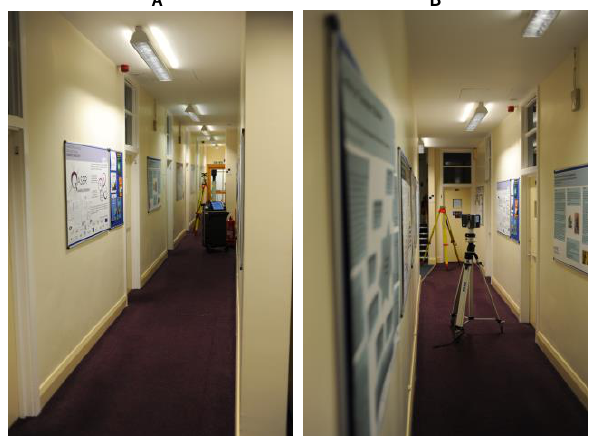
Figure 4. Views of the office as illustrated in Figure